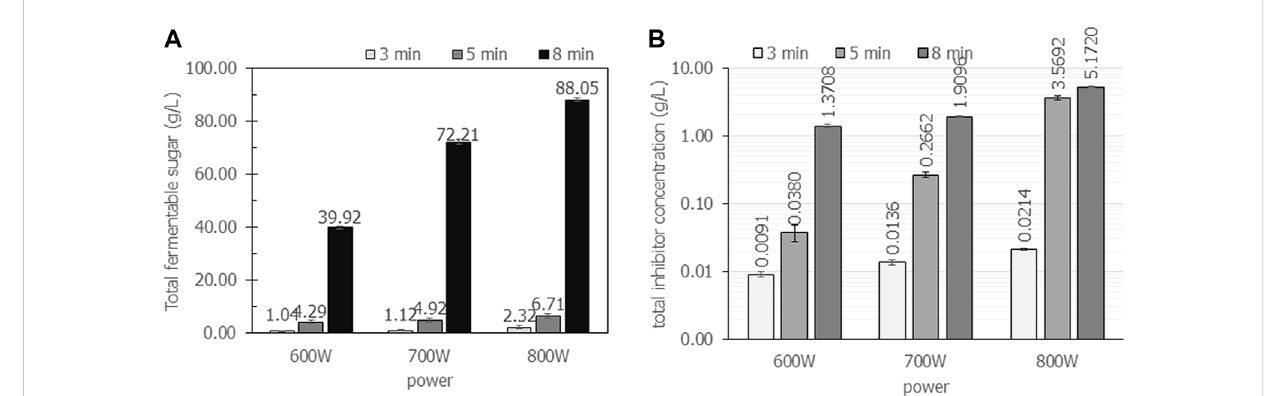
FIGURE 4 The total concentration of fermentable sugars and inhibitors when cassava pulp was hydrolyzed with liquid-to-solid ratios of 20 mL/g using 2.5%